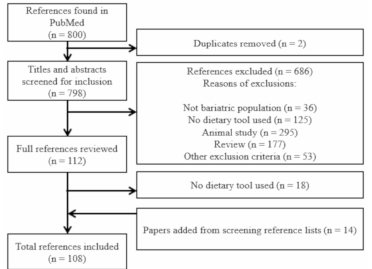
Figure 1. Flowchart for selection of included references.